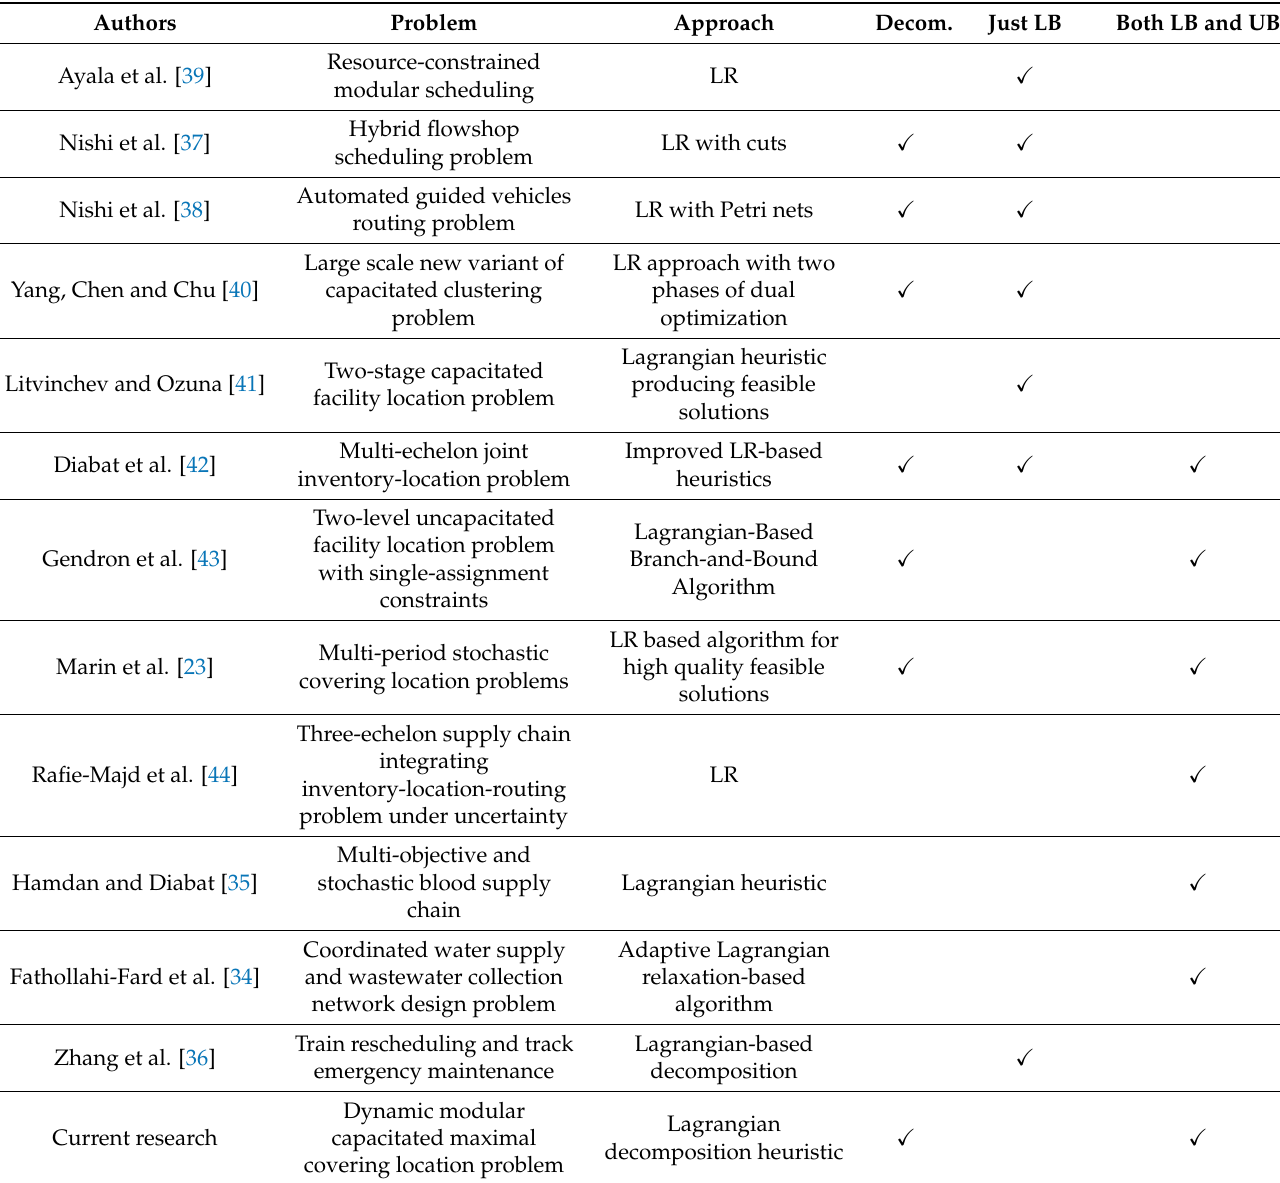
Table 1. Investigated studies using different approaches of Lagrangian relaxation